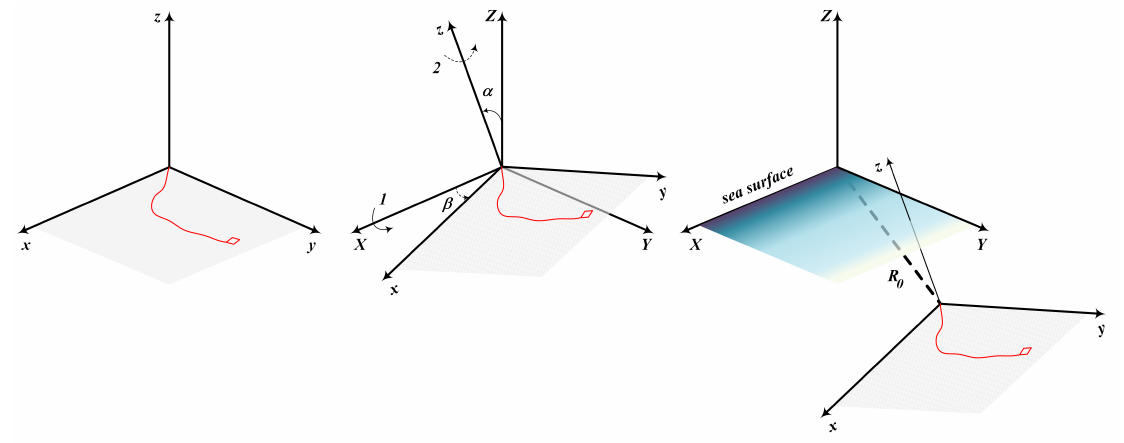
Figure 1. Target and observer coordinate